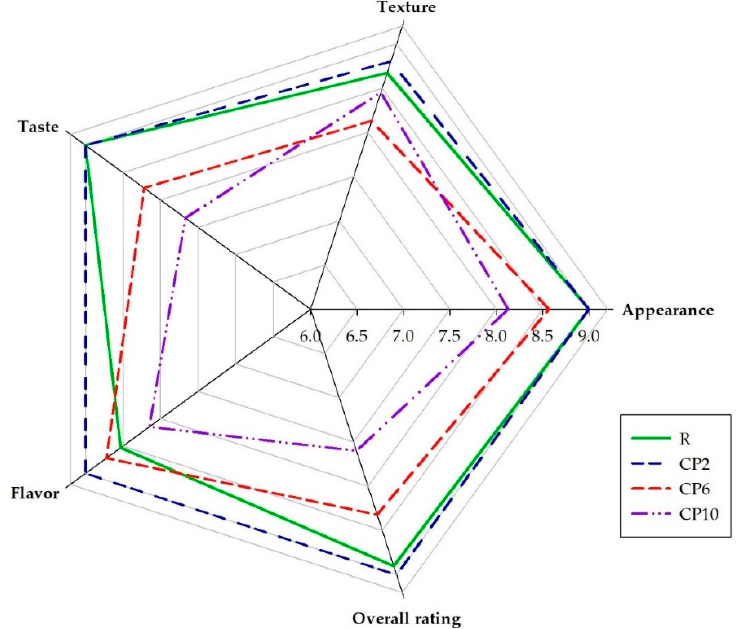
Figure 1. Results of consumer acceptance study. R—reference biscuits; CP2, CP6, and CP10—biscuits with 2%, 6%, and 10% of wheat flour replacement with CP,